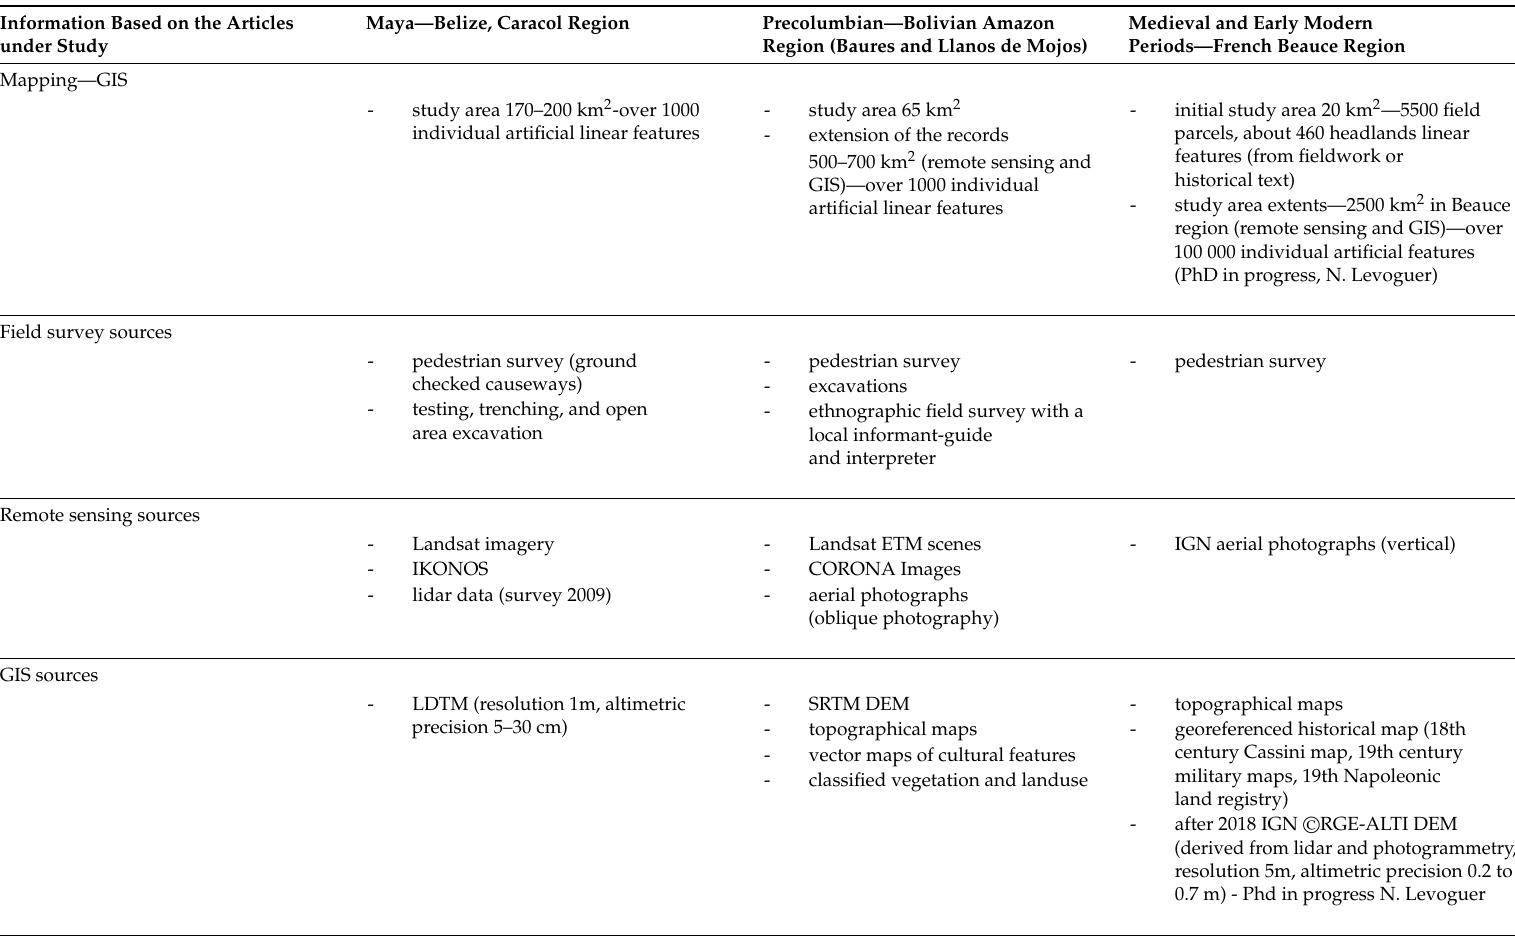
Table A1. Overview of the three case studies discussed in Section